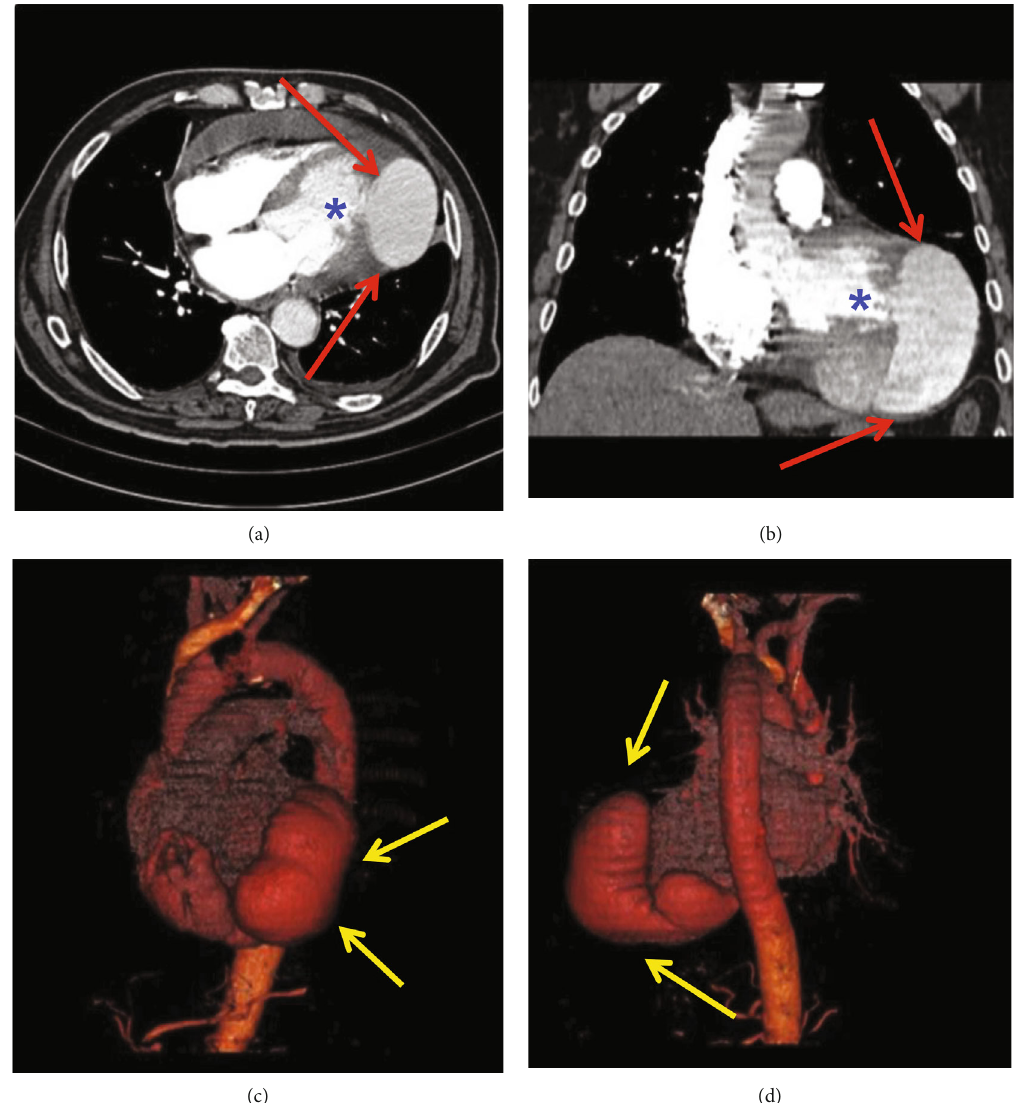
Figure 3: Chest computed angiotomography. (a, b) Large pericardial e ff usion (red arrows) and area of discontinuity in the posterolateral myocardial wall of the left ventricle communicating with the pericardial sac (blue asterisk). (c, d) Three-dimensional reconstruction by computed angiotomography revealing left ventricle giant pseudoaneurysm (yellow